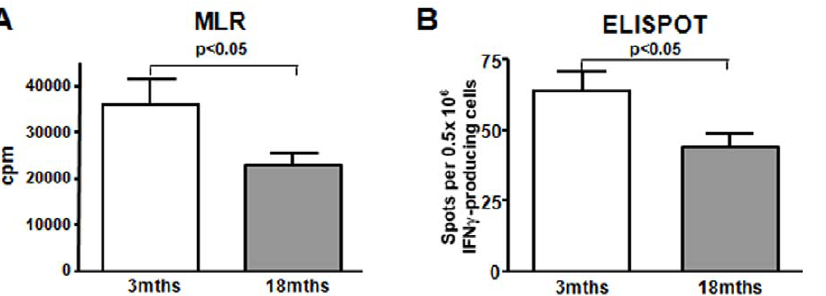
Figure 4. Impaired immune response in old WT recipients. Old WT animals demonstrate an impaired immune response after transplantation: Both, T-cell proliferation ( A ) and alloreactive IFN c -production ( B ) were significantly reduced in aged mice indicating a poor T-cell response upon re- stimulation in vivo (n=6).